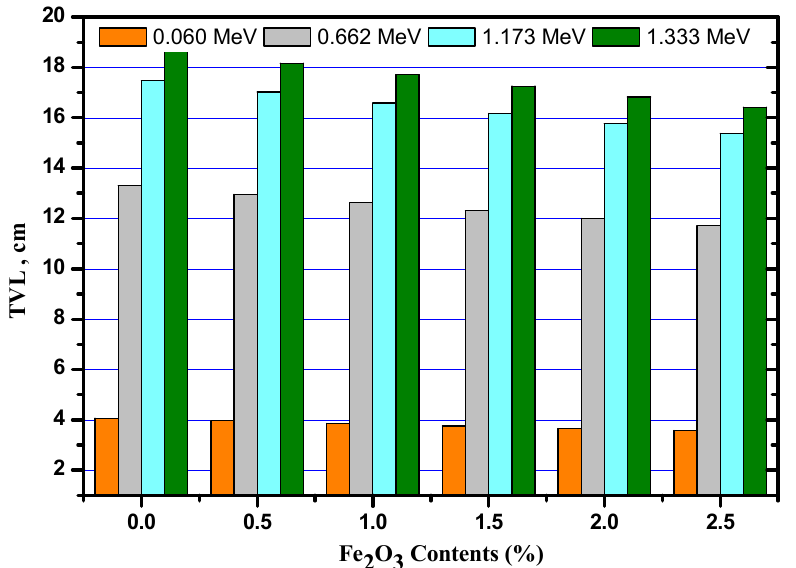
Figure 8. The relation between the TVL and the concentrations of Fe 2 O 3 nanoparticles at different energies.